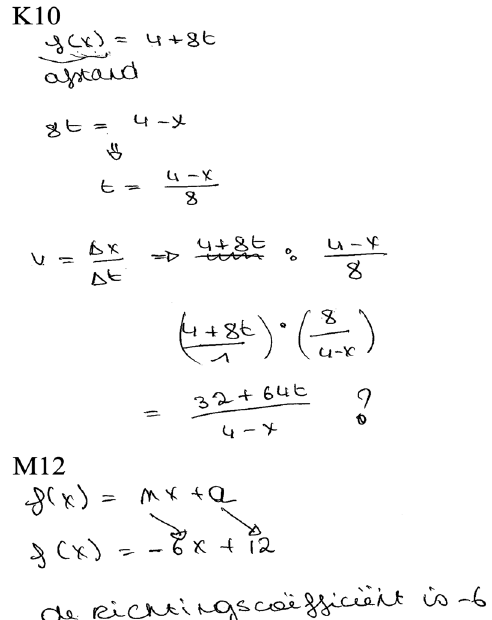
velocity.FIG. 10. Example of case 2 with question K10 in which equation x ¼ 4 þ 8 t was provided: an algebraic interval or point confusion in which the equation of motion is used for x and a manipulated version for t . The comparable question M12 from the same student is solved using strategy S1 by identifying the slope through its location in the equation, made clear by comparing with a standard form f ð x Þ ¼ mx þ q . The written explanation translates as: “ the slope is -6. ”